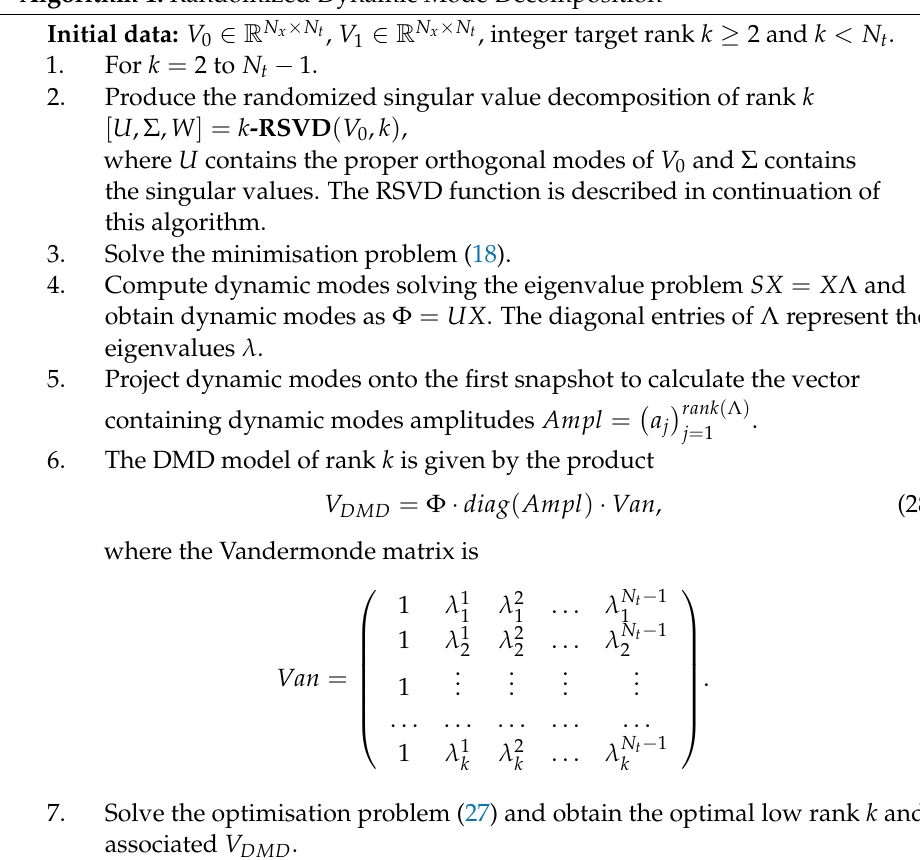
Algorithm 1: Randomized Dynamic Mode Decomposition